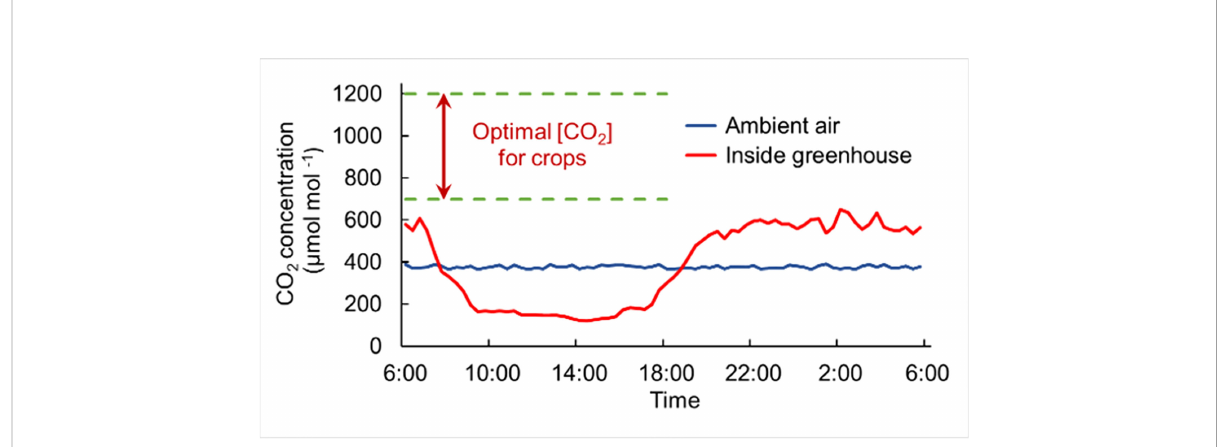
FIGURE 1 Schematic diagram of CO 2 de fi ciency in greenhouse production. CO 2 in the greenhouse (red curve) accumulates at night due to crop respiration, while the CO 2 concentration decreases sharply after light exposure due to CO 2 absorption by crops through photosynthesis, which is far below the crop demand (the range within green dotted lines), almost the whole daytime. The blue curve represents the CO 2 level in the ambient air outside. The data for plotting the line graphs refer to the text in Zhang et al. (2014); Noctor and Mhamdi (2017); Dong et al. (2018); Li et al. (2018), and fi gures in Sa ́ nchez-Guerrero et al. (2005) and Kläring et al.